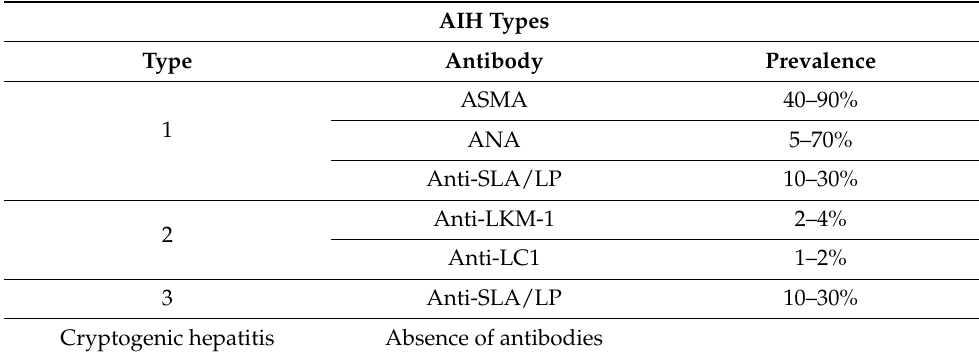
Table 1. Autoimmune hepatitis (AIH) classification according to the presence of autoantibodies based on